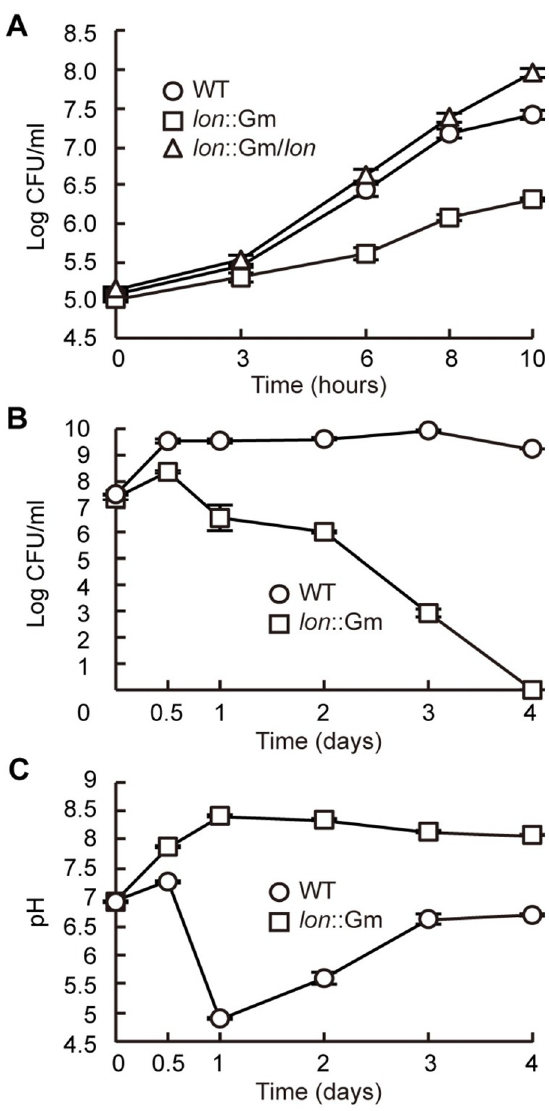
Fig 2. Cell viability and extracellular pH of the lon mutant of B . glumae . (A) B . glumae strains were subcultured in LB medium with 20 × dilution after adjusting samples to an O.D 600 of 0.05. CFUs were determined from serial dilution of 100 μ L aliquots of each sample at the designated time points. The lon mutant had a significantly lower initial growth rate than that of the wild type. (B) B . glumae strains were subcultured in LB medium following adjustment of samples to an O.D 600 of 0.05. The population density of the lon mutant decreased gradually after 12 h, leading to a population crash. (C) The extracellular pH of the strains was measured at each time point using a pH meter. wild type BGR1 at two different population densities, approximately at 1.28 × 10 8 and 1.33 × 10 9 CFU/mL, as the lon mutant did not reach the maximum population density. AI sig- nals were detected at 1.28 × 10 8 CFU/mL but much higher levels were observed at 1.33 × 10 9 CFU/mL of wild type BGR1 (Fig 3A). However, the lon mutant produced no detectable QS sig- nals, and the genetic complementation resulted in recovery of QS signal biosynthesis to the wild type level (Fig 3A). As the failure of the lon mutant to reach maximum growth capacity might be one reason that the mutant did not produce detectable amounts of QS signals, we harvested cells from 10 culture tubes, each containing 3.57 × 10 8 CFU/mL, and pooled them to